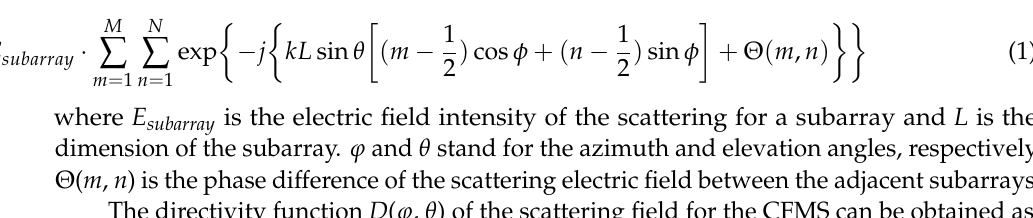
Figure 3. Simulated 3D scattering patterns for a metal plate, the CFMS of all “0” units and the CFMS with checkerboard structure with the same area at 4.79 GHz. ( a ) 3D scattering pattern of a metal plate. ( b ) 3D scattering pattern for the CFMS of all “0” units. ( c ) 3D scattering pattern of the CFMS with checkerboard structure.